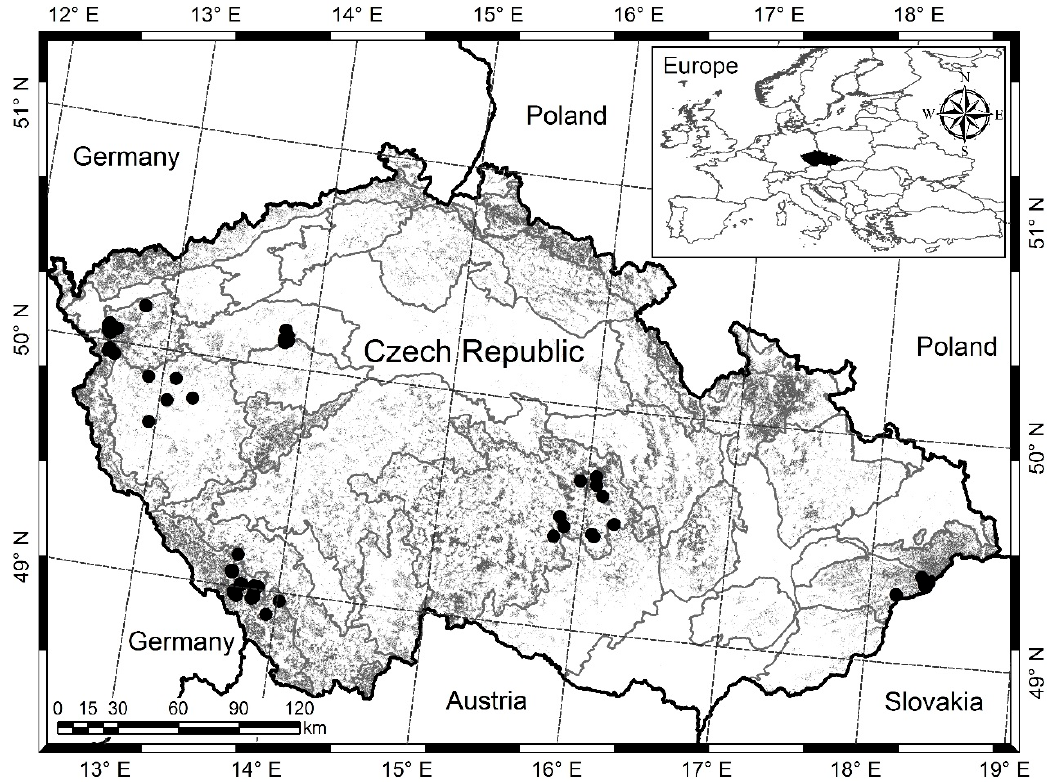
Figure 1. Location of 76 research plots with Norway spruce forest stands (black dots); gray lines showing separating Natural Forest Areas and gray areas forest cover with dominating Norway spruce in the Czech Republic. The dominating spruce layer was created by classifying ESA Sentinel-2 satellite images by pixel sorting based on spectral spruce response during phenological vegetation phases using data collected during the National Forest inventory. The author of the tree species determination method was Dr. Filip Hájek, the author of the spruce layer was Ing. Markéta Kantorová, data source ÚHÚL Brandýs nad Labem, and software ArsGis (Esri). Sample plots were chosen to represent various stands of Norway spruce and site conditions. Elevation of the studied forests ranges from 380 m to 1040 m above sea level and the majority of